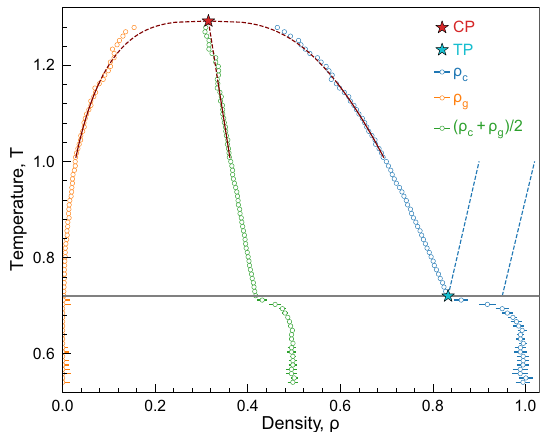
Figure 1. Gas-liquid binodal for the LJ12-6 system: The orange and blue symbols are densities of gas and condensate obtained through fitting MD data by Eq. (6). The green symbols are median ρ m = (ρ g + ρ c )/ 2 . The solid red line is a fit by Eq. (7). The triple and critical points (CP and TP, respectively) are indicated by red and blue stars, respectively.